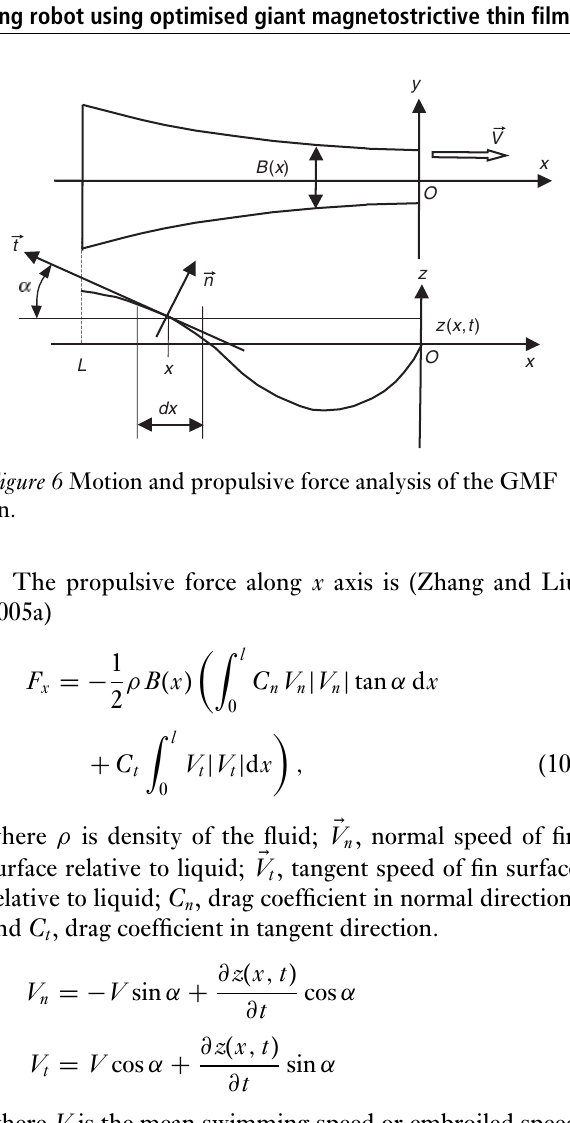
where V is the mean swimming speed or embroiled speed along axis; α , angle between tangent of caudal fin and axis x . For minor vibration, α = ∂ z ( x , t ) /∂ x